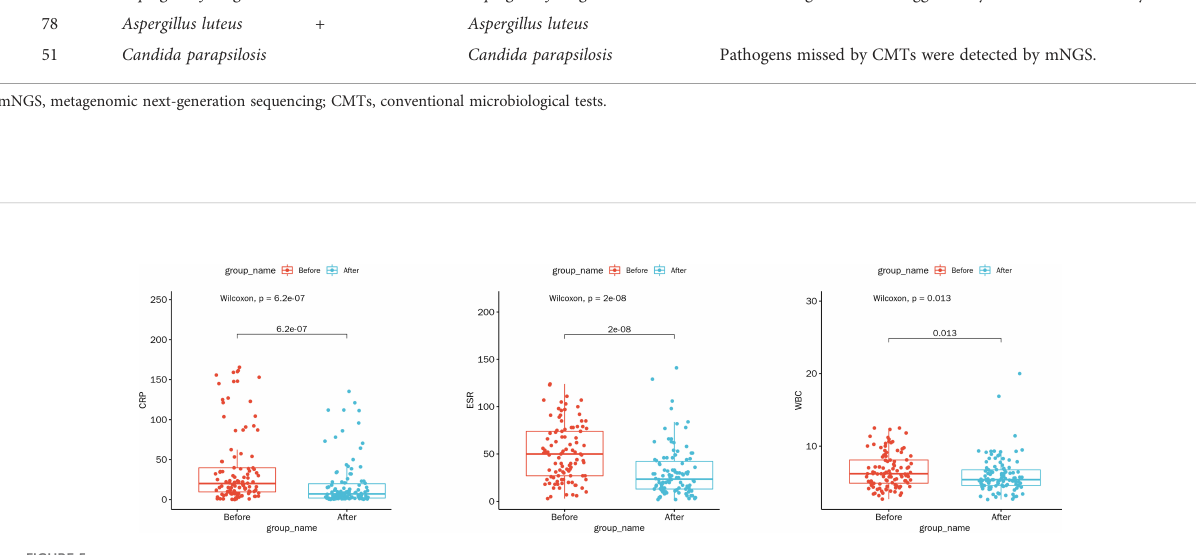
FIGURE 5 Comparison of laboratory indicators at the time of hospitalization and hospital discharge under the mNGS-guided treatment. Abbreviations: WBC, white blood cell count (10 9 /L); ESR, erythrocyte sedimentation rate (mm/h); CRP, C-reactive protein